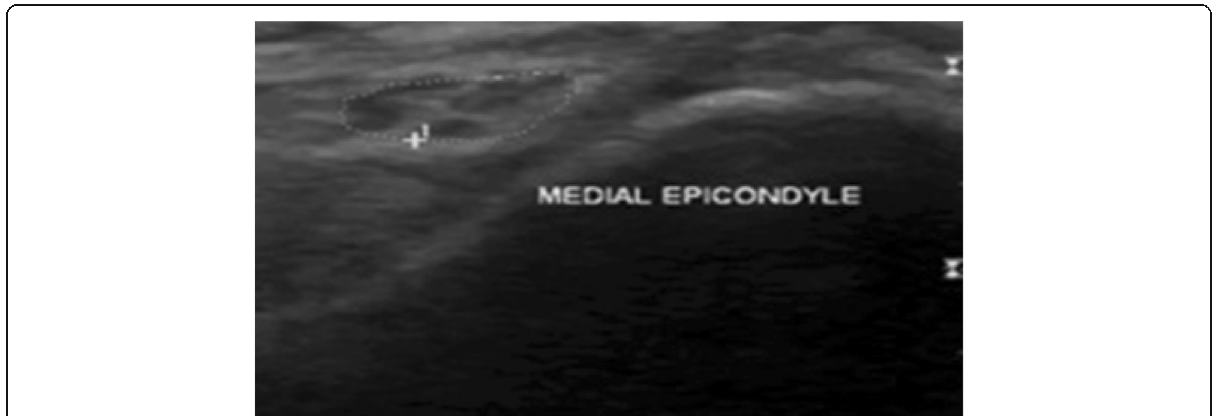
Fig. 1 Transverse scan of the ulnar nerve at the retro-epicondyle groove. CSA (cross-sectional area) measured using a direct tracing method excluding the epineurium